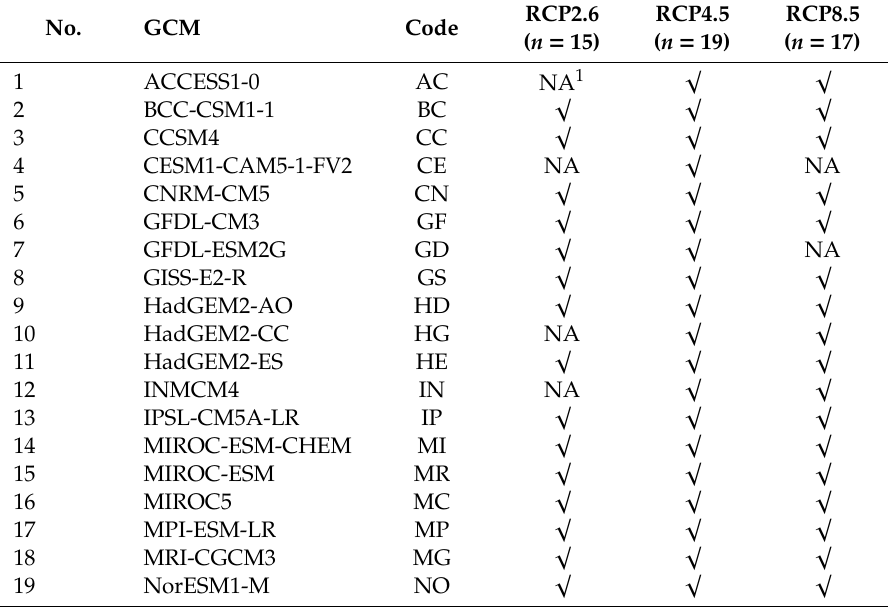
Table 1. Climatic data in raster format of 30 arc-sec (~1 km 2 ) based on 19 GCMs for the three climate change scenarios (RCP2.6, RCP4.5 and RCP8.5) according to IPCC5 / CMIP5 (WorldClim database [39]). No. GCM